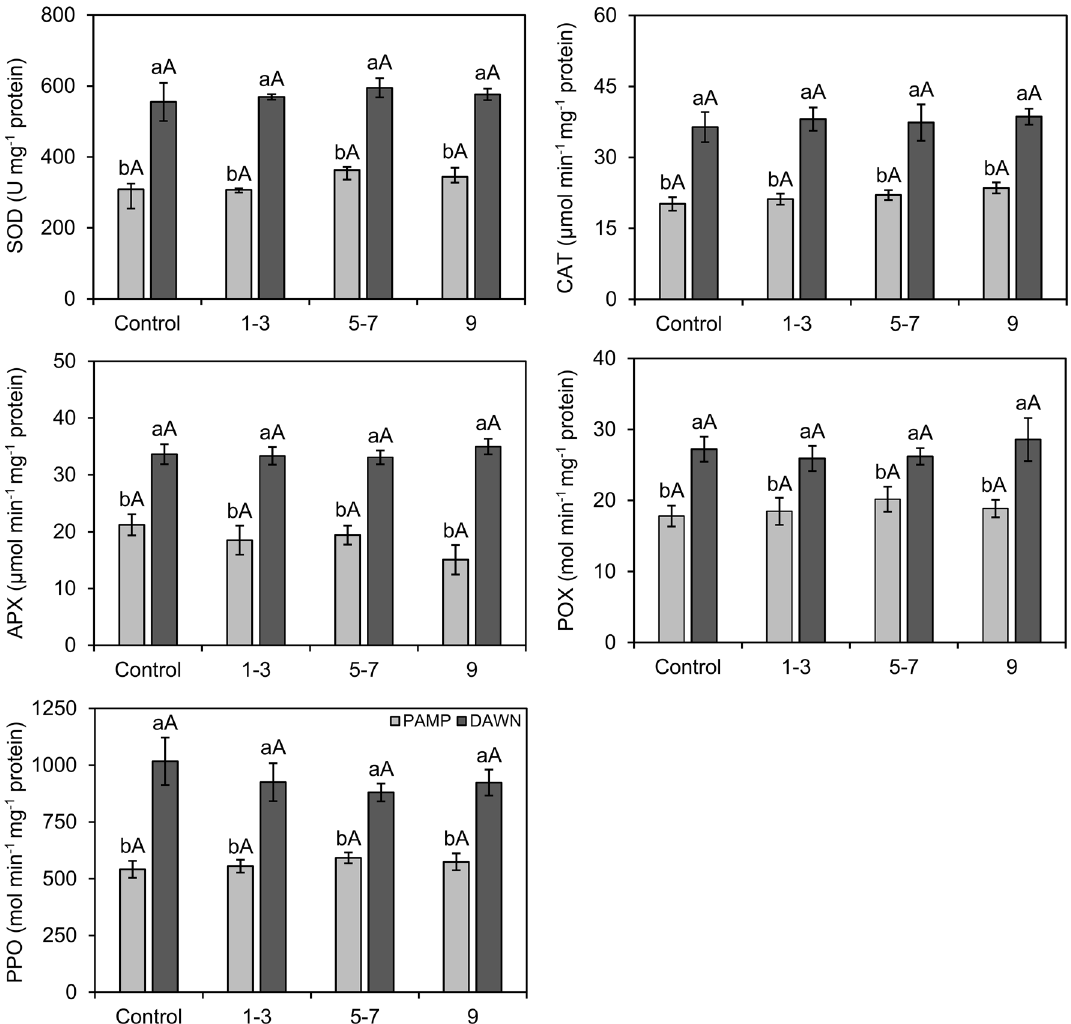
Figure 6. Activities (± SE) of superoxide dismutase (SOD), catalase (CAT), ascorbate peroxidase (APX), peroxidase (POX), and polyphenol oxidase (PPO) in rice root from susceptible (Ss) and resistant (Rr) cultivars with different levels of natural infestation of the South American rice water weevil Oryzophagus oryzae at 25 Days After Flooding (DAF). Rice cultivars: PAMP = BRS Pampa CL (Ss) (light gray columns); DAWN = Dawn (Rr) (dark gray columns). Levels of natural infestation of larvae on plants selected for biochemical analysis at 25 DAF (larvae infestation peak in the field) = 1 (control): 0 larva; 2: 1–3 larvae; 3: 5–7 larvae; 4: 9 larvae. Different lowercase letters above bars denote significant differences among rice cultivars at each infestation level, whereas different uppercase letters above bars denote significant differences in the same rice cultivar among infestation level, both by the Scott Knott test ( P ≤